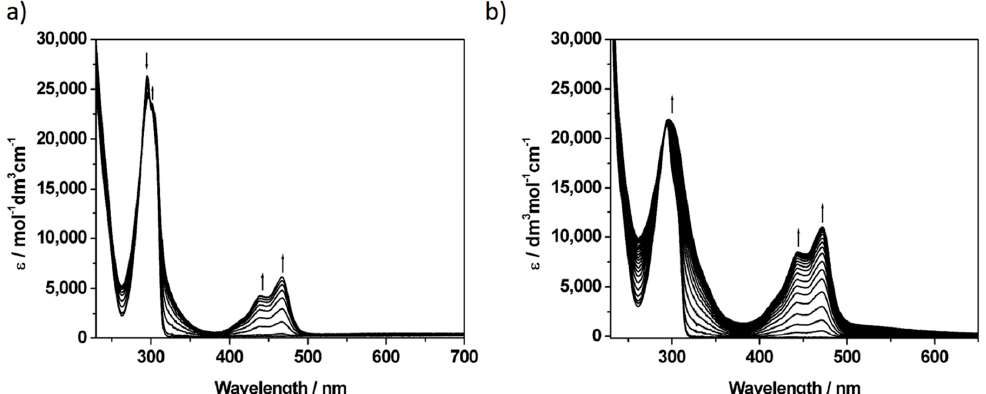
Figure 2. UV-vis absorption spectra showing ( a ) the inter-conversion of redox states in P5A between P5A and [P5A]+ (potential A) ( b ) the inter-conversion of redox states in [P5A-Rot] 2+ upon oxidation at potential A. See Figure 1 for potentials applied. Spectra were recorded in CH 2 Cl 2 containing [ n Bu 4 N][BF 4 ] (0.4 M) as the supporting electrolyte at 273